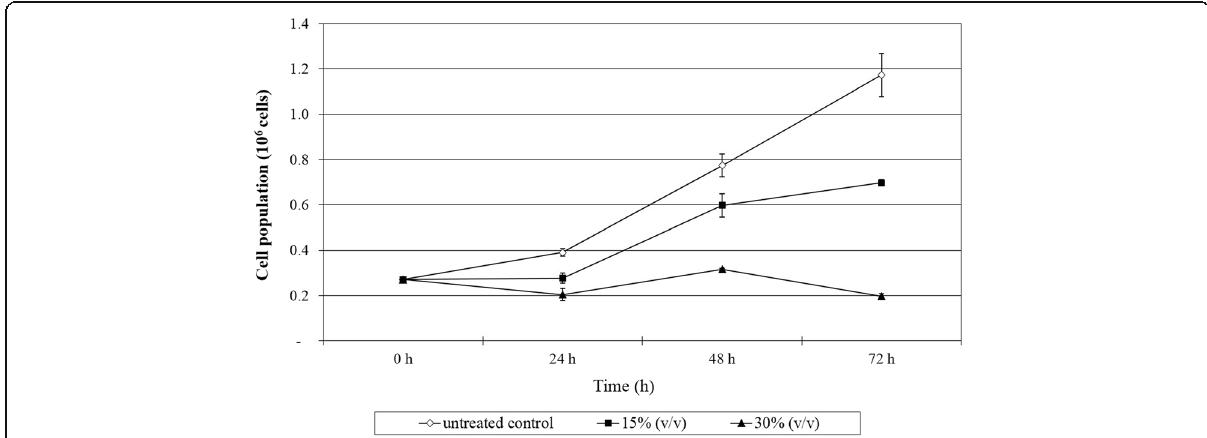
Fig. 4 Antiproliferative effect of PM produced by Lactobacillus plantarum RG14 on HT-29 cells determined via trypan blue staining and cell count. Cell population equals to the viable cell concentration of a single well multiplied with 100 μ l of complete growth media used to suspend the cell pellet. Values within the same row and experiment having an asterisk indicate significant difference (P < 0.05) from the untreated control groups. Error bars represent the standard error of the mean